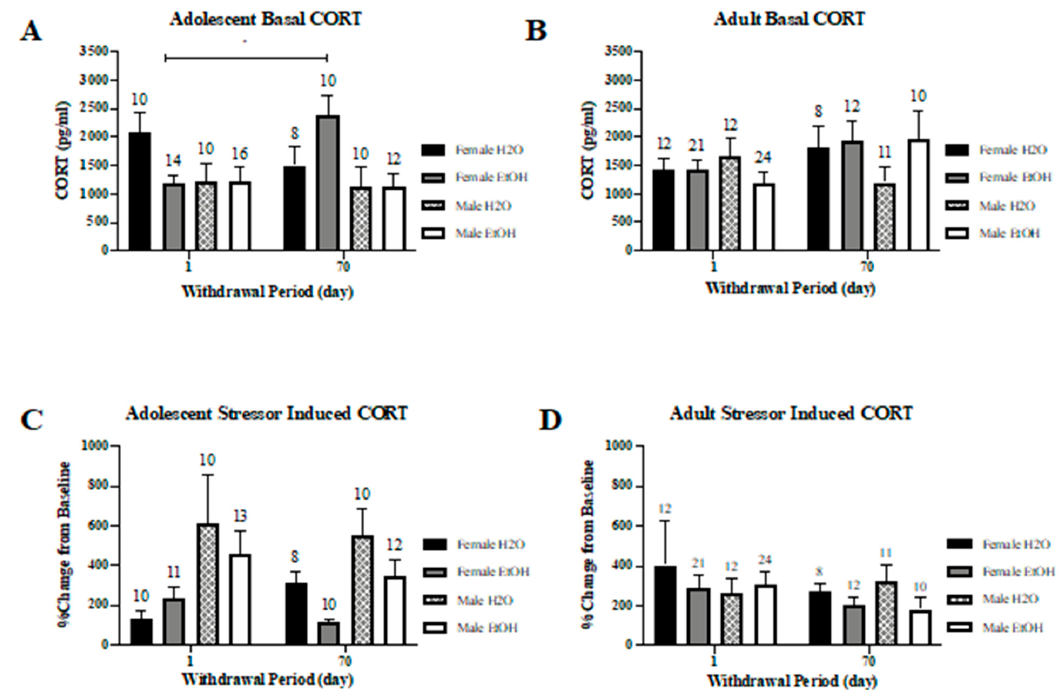
Figure 12. Summary of the subject factor interactions observed regarding plasma corticosterone (CORT). ( A ) Depiction of the Sex × Drinking × Withdrawal interaction observed for adolescent-onset drinking mice versus ( B ) the lack thereof for adult-onset drinking animals. ( C ) Depiction of the Sex × Drinking × Withdrawal interaction for stressor-induced corticosterone levels in adolescent-onset mice. ( D ) Depiction of the lack of group differences in stressor-induced corticosterone levels in adult-onset animals. The data represent the means ± SEMs for the numbers of mice indicated in each panel. * p < 0.05 WD1 vs. WD70 for female EtOH.